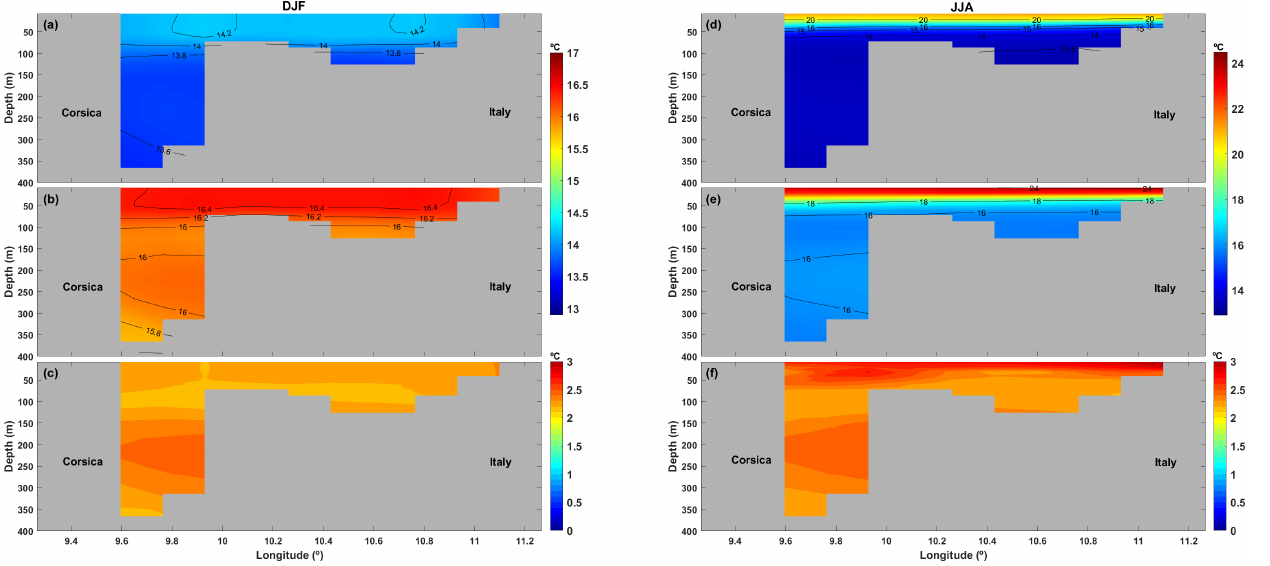
Figure 7. This is equivalent to Fig. 6 but constructed for the Corsica Channel.